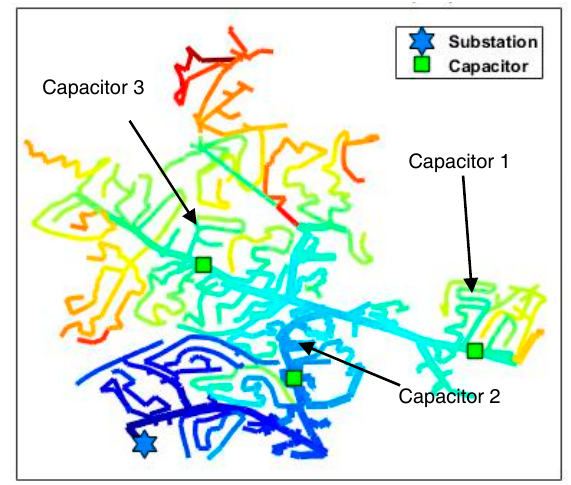
Figure 3. Detailed one-line diagram of the test circuit (Feeder 1) [32].